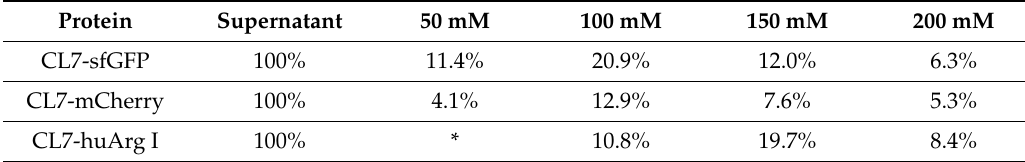
Table 1. Recovery e ffi ciency of CL7 fusion protein purified by Ni 2 + -a ffi nity chromatography. Protein